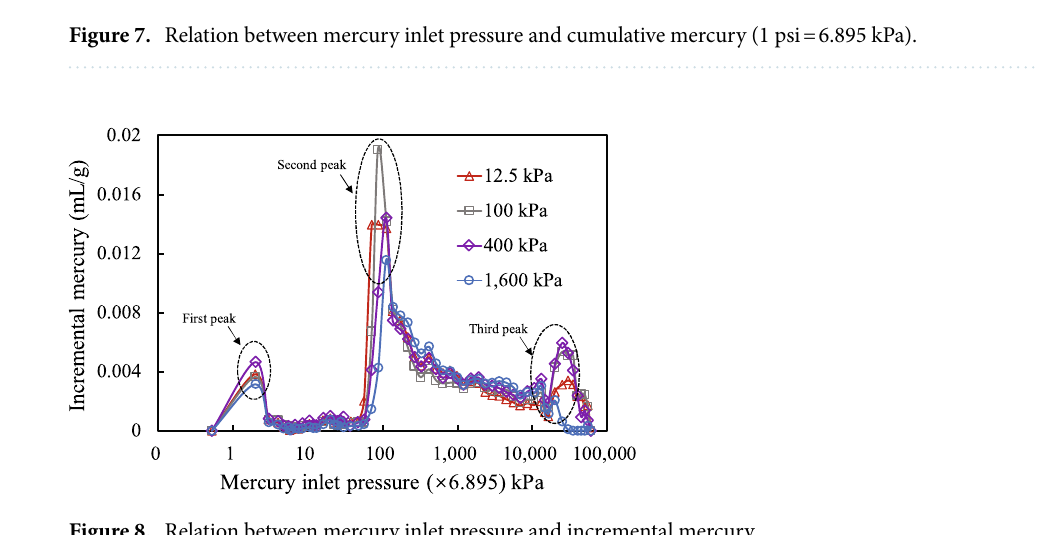
Figure 8. Relation between mercury inlet pressure and incremental